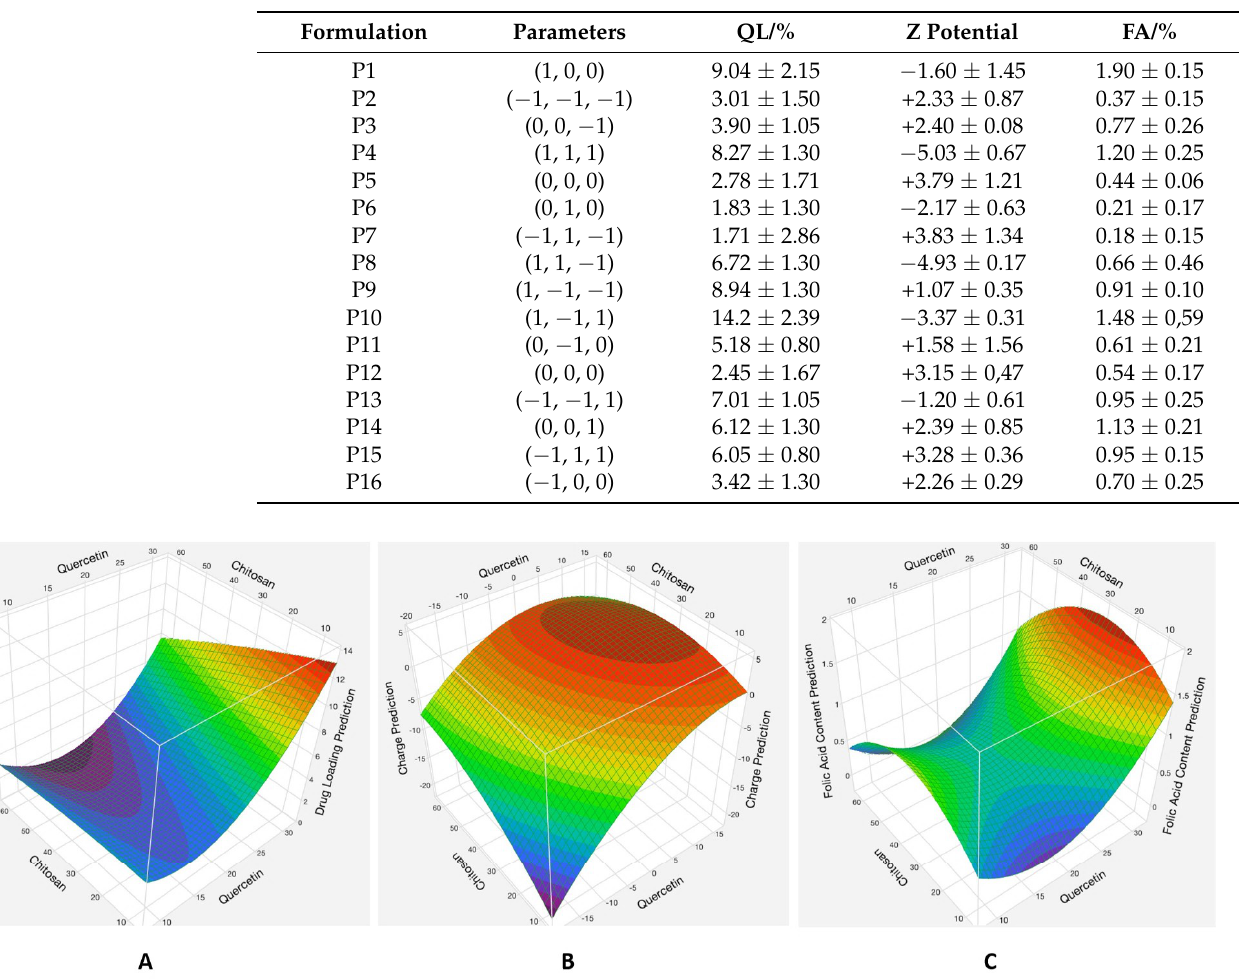
Table 2. Responses obtained using varying amounts of quercetin, chitosan, and folic acid, where QL = quercetin loading, Z potential = zeta potential, FA = folic acid content.